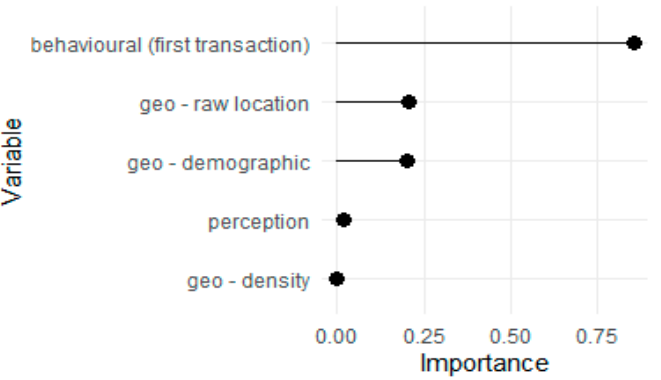
Figure 11. Variable importance plots for the model with all variables.